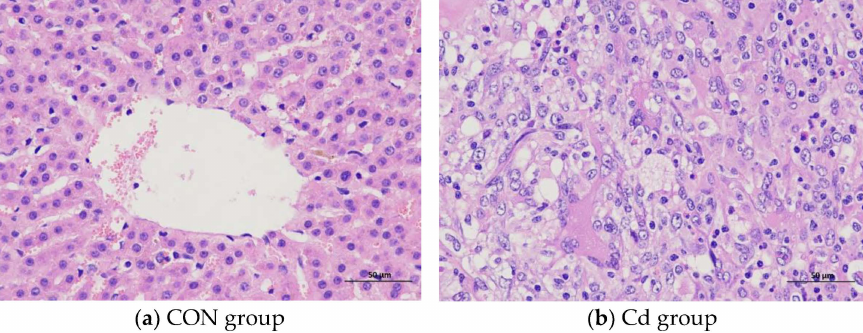
Figure 1. Histopathological changes of the liver in the Guizhou black goat (HE ×